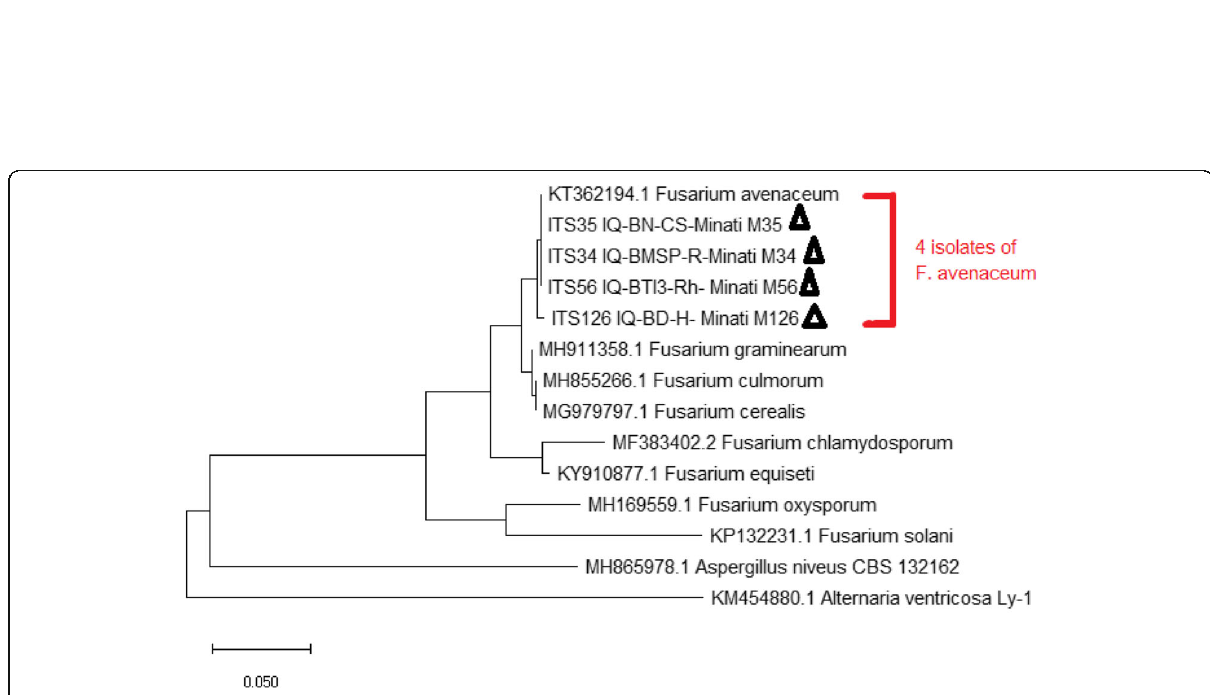
Fig. 7 Phylogenetic tree generated with the ITS-rDNA sequences of the Fusarium avenaceum (4), as inferred from the maximum likelihood (ML) analyses (determined by black triangles) and related species retrieved from GenBank. ITS sequences of Aspergillus niveus (MH865978) and Alternaria ventricosa (KM454880) were used as the out-group